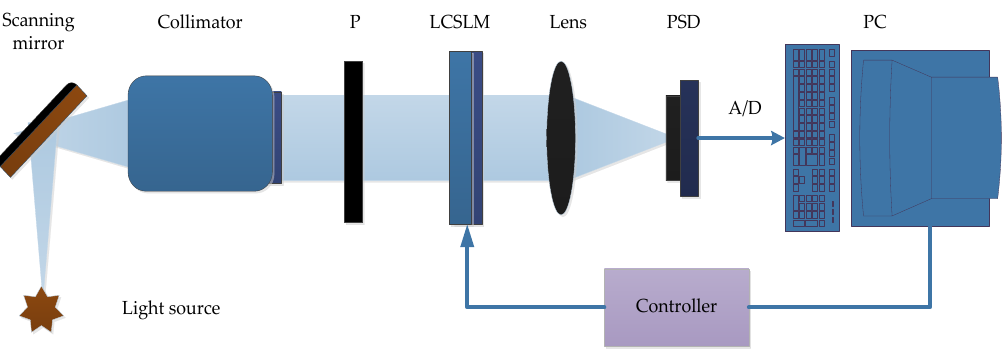
Figure 8. Schematic diagram of line of sight correction system.